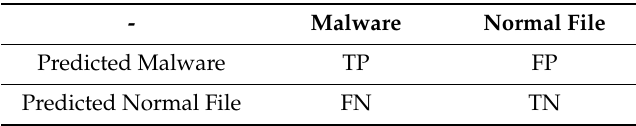
Table 3. Confusion Matrix.